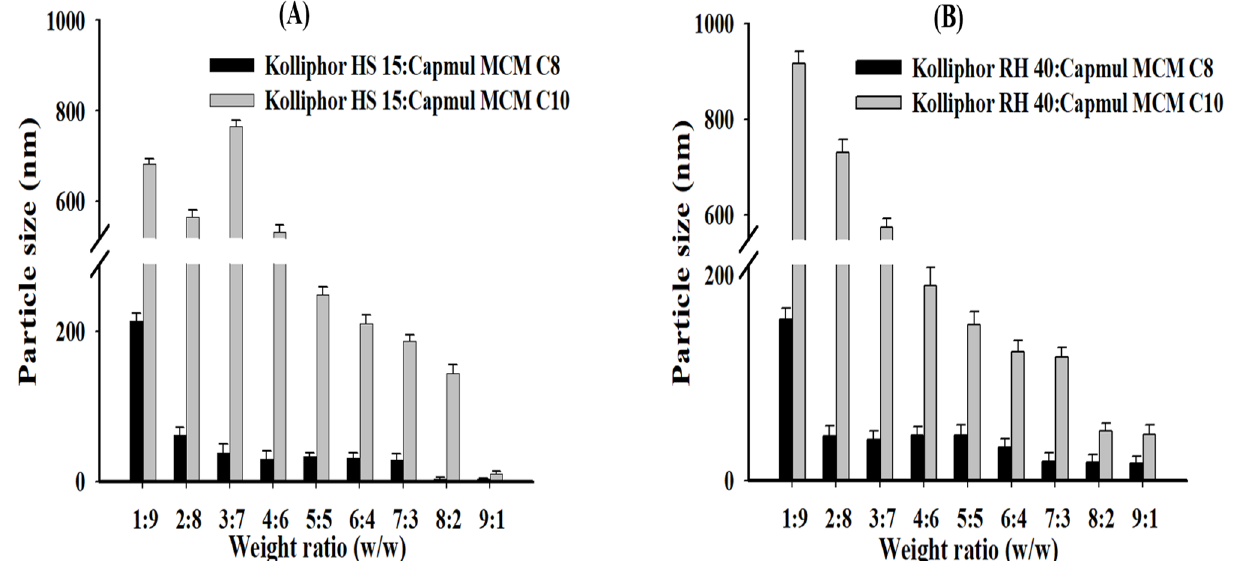
Figure 3. Particle size of vehicle dispersion in water according to the weight ratios between surfactant and oil; ( A ) Kolliphor HS 15:Capmul MCM C8 and Kolliphor HS 15:Capmul MCM C10; ( B ) Kolliphor RH 40:Capmul MCM C8 and Kolliphor RH 40:Capmul MCM C10.